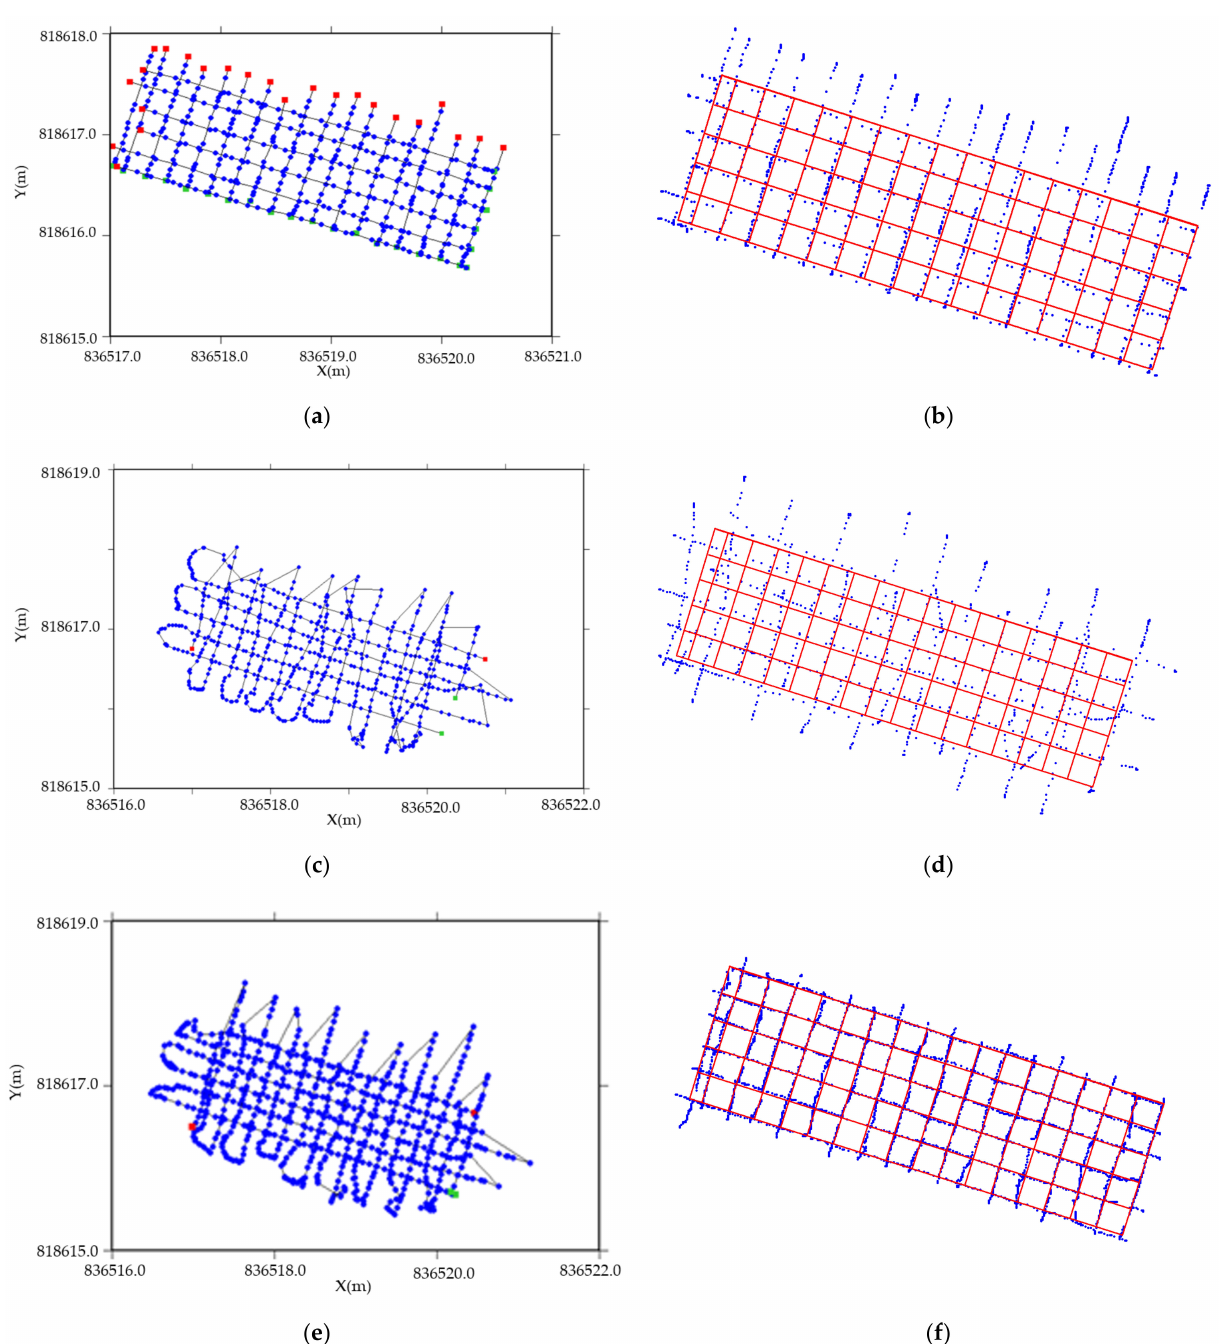
Figure 9. ( a , c , e ) The survey paths of methods T1, T2, and T3, respectively. ( b , d , f ) Comparisons of these paths with the designed path